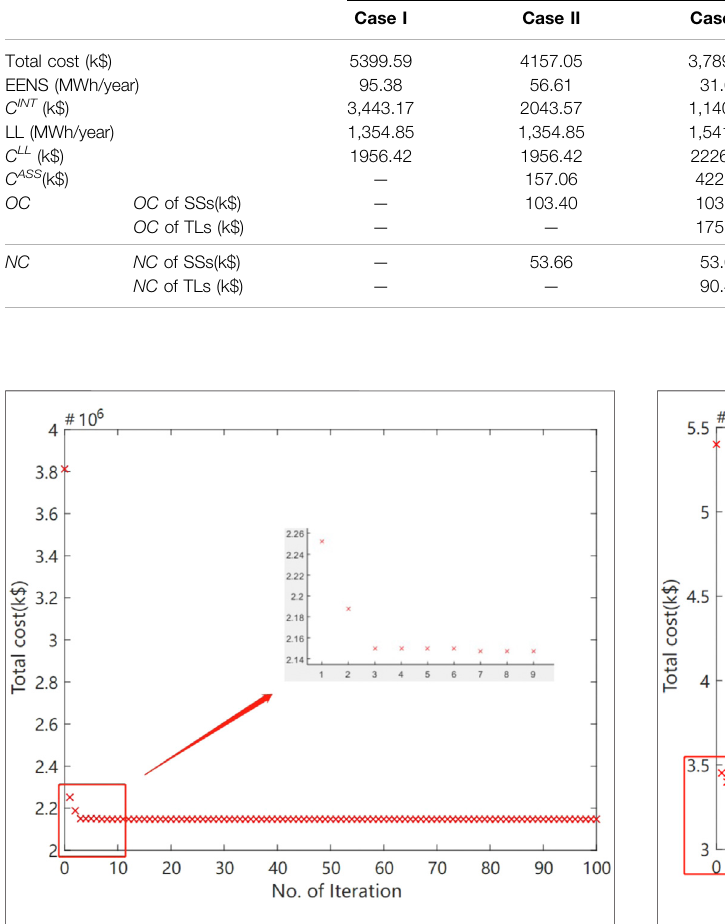
FIGURE7| Convergencecharacteristicoftheproposedmodelforbus2 FIGURE8| Convergencecharacteristicoftheproposedmodelforbus4